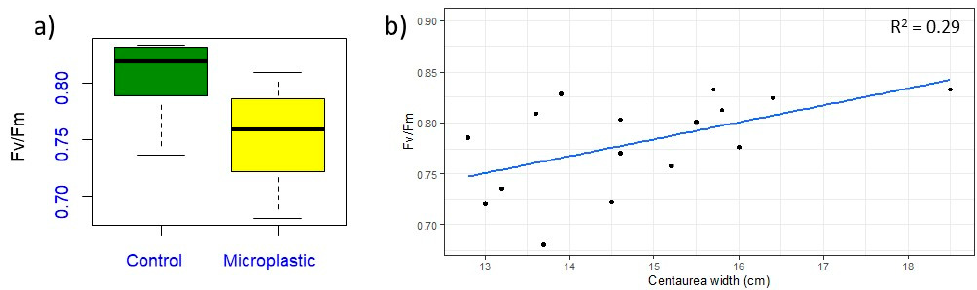
Figure 4. ( a ) Photosynthetic efficiency of C. cyanus , expressed as the index Fv/Fm, significantly differed between control and treatment; ( b ) increasing trend of photosynthetic efficiency with plant width.